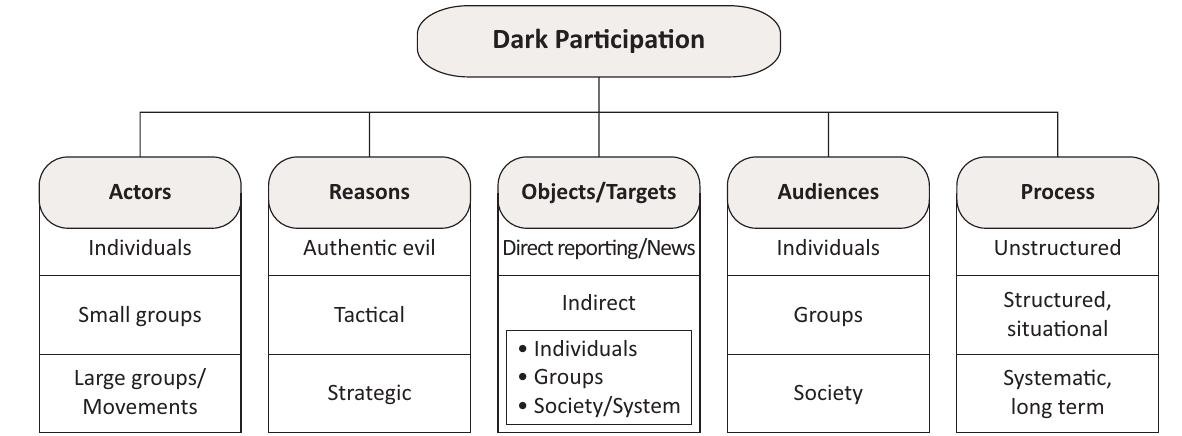
Figure 1. Variants of dark